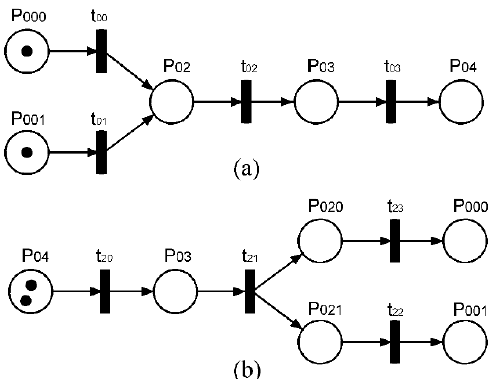
Figure 17. The Petri nets of the shedding process and closing the shed when the locking device and the sliding table move simultaneously. ( a ) The net of transitions t 0 ; ( b ) the net of transitions t 2 .